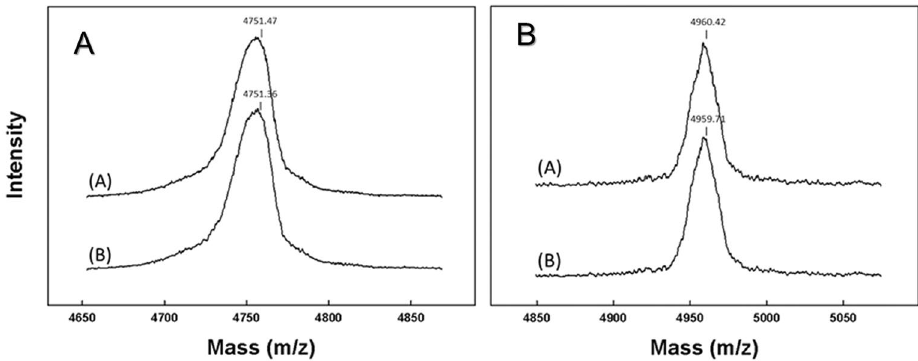
Figure 7. Maldi TOF mass spectra of the four dry powder surfactant preparations from the 2nd series (SMB or B-YL peptide with Lactose or Trehalose as excipient). Figure A on the left: ( A ) SMB: Lactose surfactant (DPPC:POPG:SMB:Lactose:NaCl 49:21:3:25:2) and ( B ) SMB: Trehalose surfactant (DPPC:POPG:SMB:Trehalose:NaCl 49:21:3:25:2). Figure B on the right: ( A ) B-YL: Lactose surfactant (DPPC:POPG:B-YL:Lactose:NaCl 49:21:3:25:2) and ( B ) B-YL: Trehalose (DPPC:POPG:B-YL:Trehalose:NaCl 49:21:3:25:2). Samples had been stored at 5 °C for 1 month before analysis by mass spectrometry. Spray drying during surfactant production did not affect the integrity of the SMB peptide in phospholipid mixtures containing either Trehalose or Lactose as